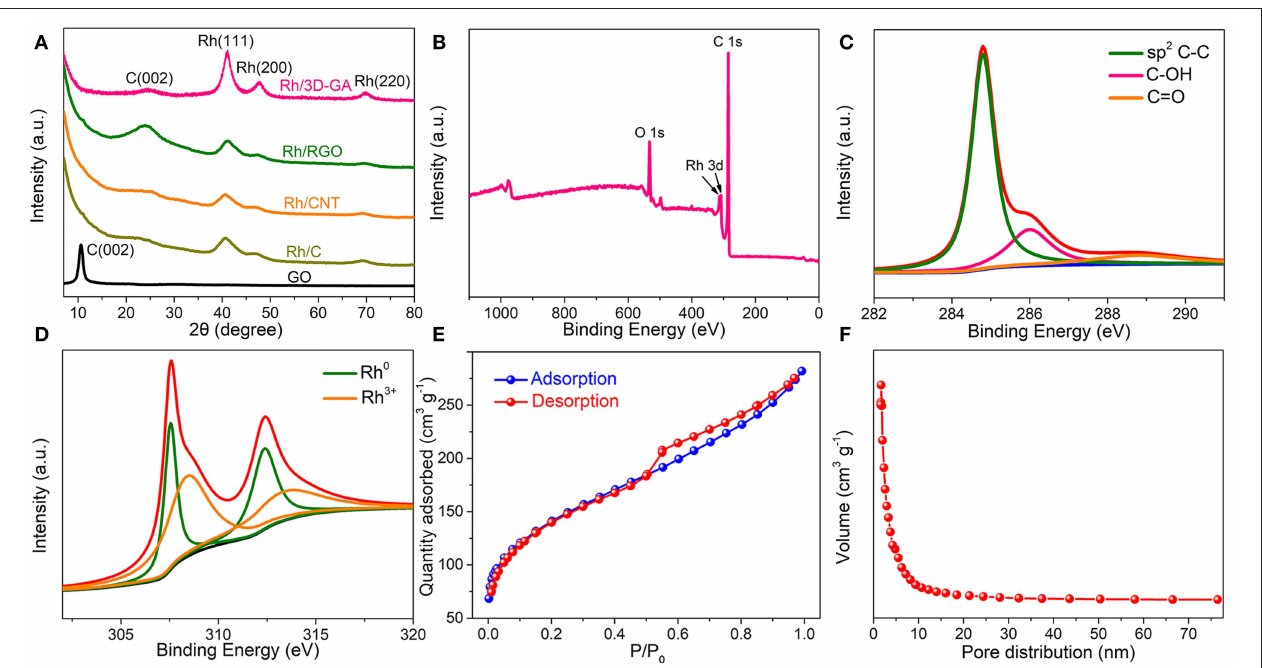
FIGURE 1 | Representative (A,B) FE-SEM, (C) TEM, and (D,E) HRTEM images of the Rh/3D-GA architecture. The inset in (C) is the Rh size distribution. (F) HAADF–STEM image and the corresponding elemental mapping analysis of (G) C, (H) O, and (I) Rh elements of a Rh-decorated graphene nanosheet.